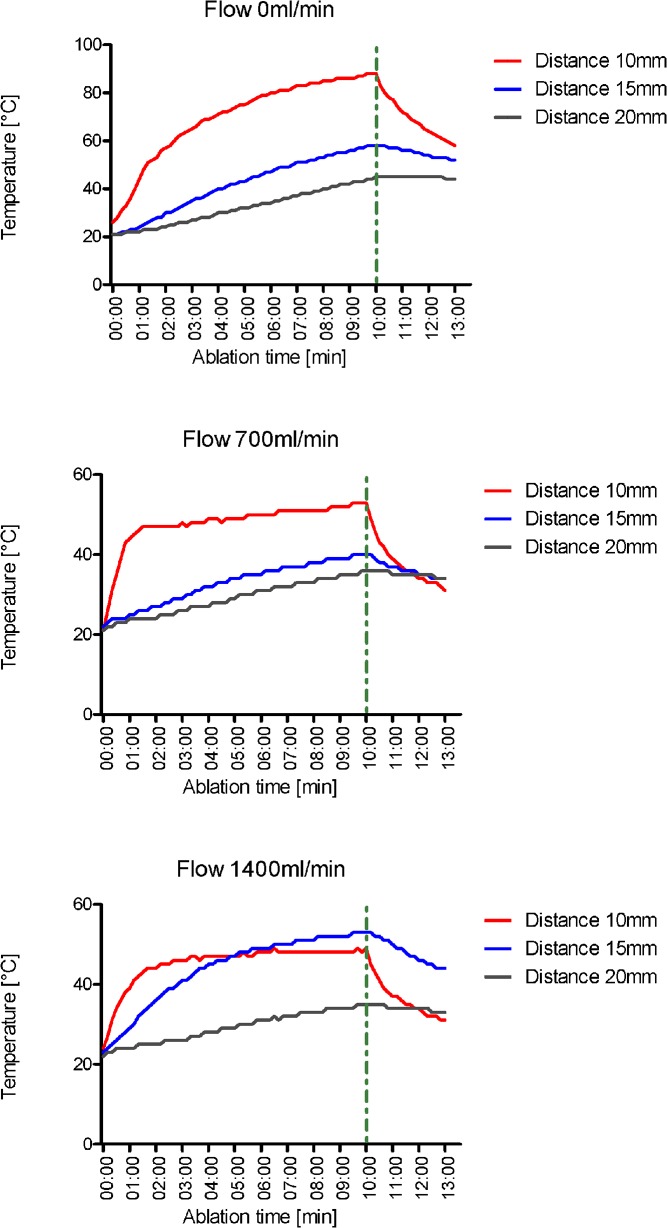
Temperature profile in ex microwave ablation of porcine liver, dependent on vessel perfusion and vessel–applicator distance.Maximum temperature during the ablation cycle decreased significantly with increasing distance between vessel and microwave antenna as well as with increasing vessel flow (p<0.05).